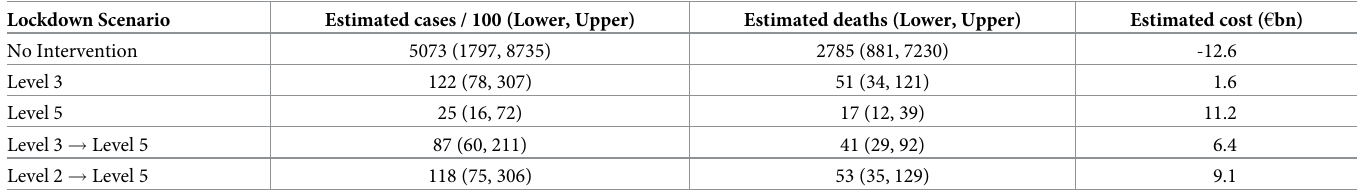
Table 3. Estimated cases, deaths and costs for the 8 week period between 1st February 2021 and 30th March 2021. Where there are two scenarios listed, the shift occurred on the 2nd March. The observed number of cases in the given period was 15,334 for the Dublin region. 95% intervals are given in